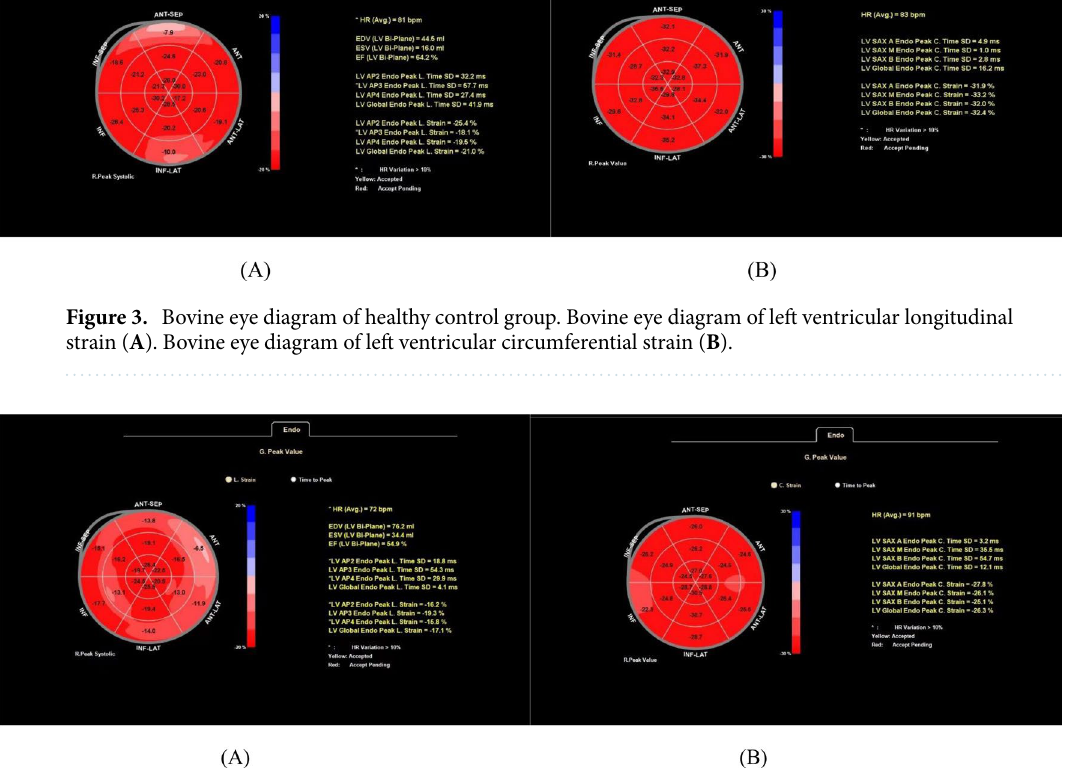
Figure 4. Bovine eye diagram of diabetic group. Bovine eye diagram of left ventricular longitudinal strain ( A ). Bovine eye diagram of left ventricular circumferential strain ( B